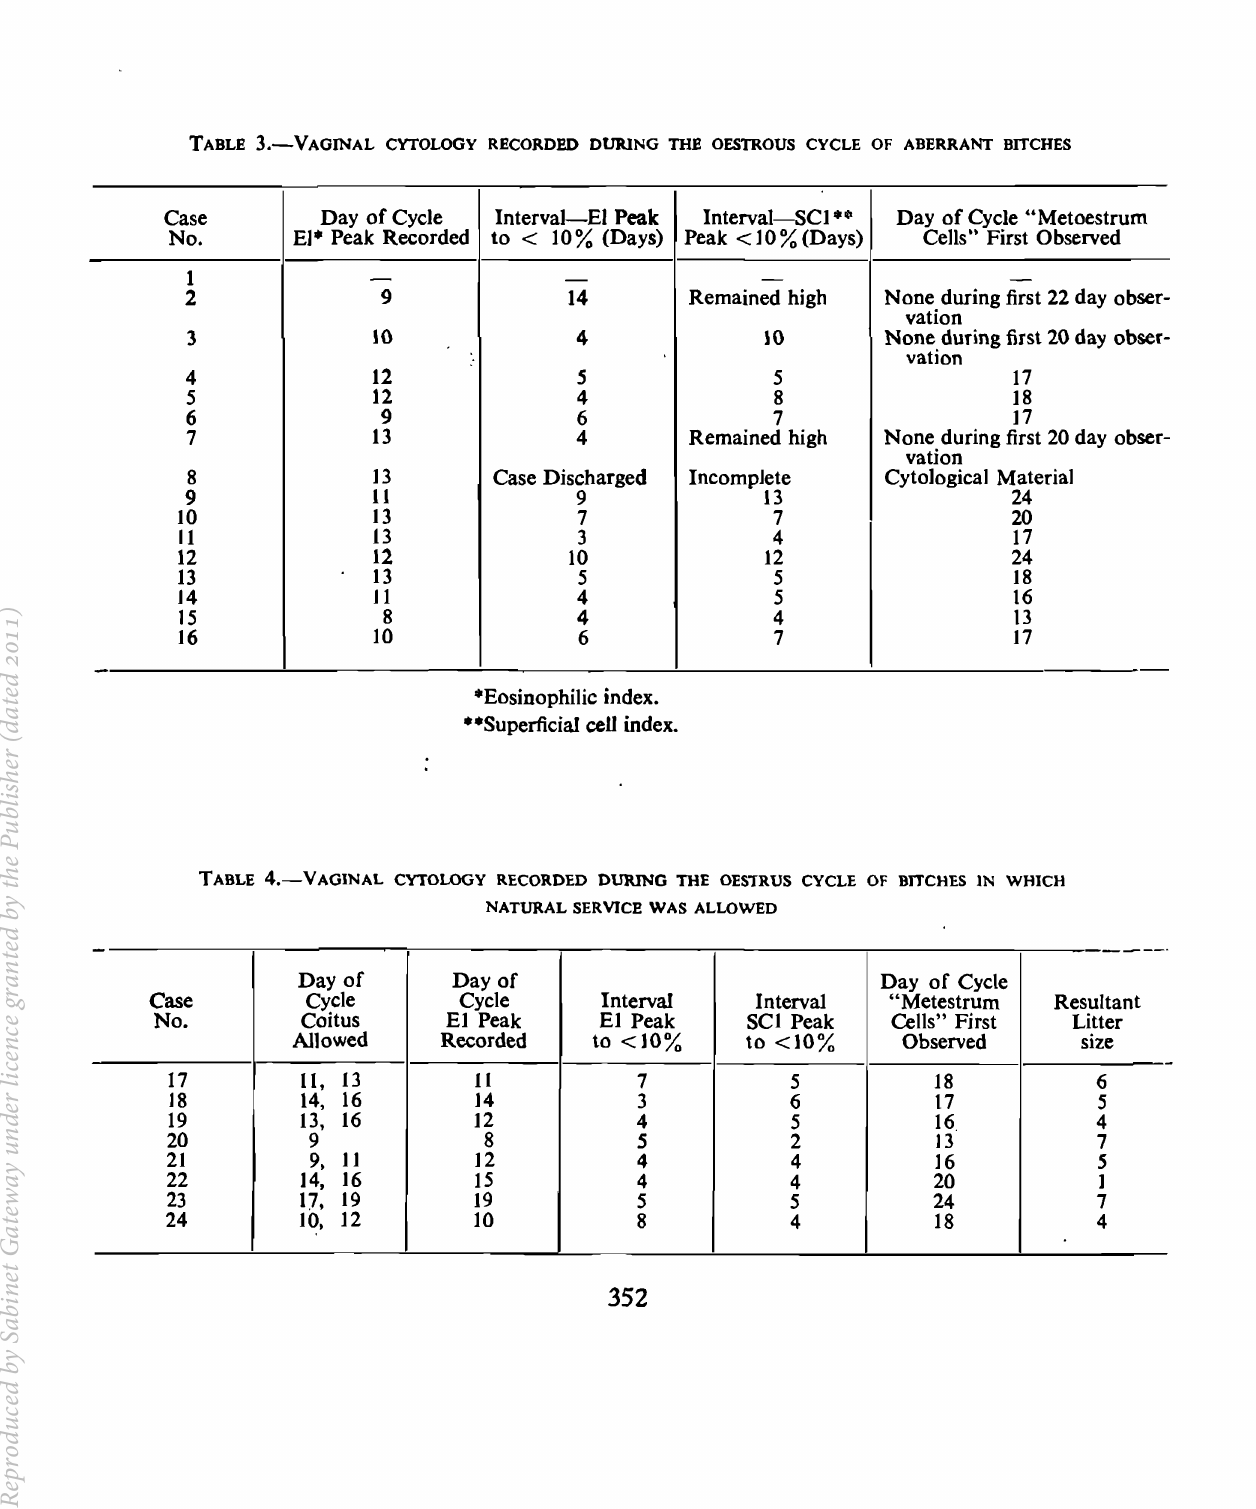
TABLE 3.-VAGINAL CYTOLOGY RECORDED DtllUNG THE OESTROUS CYCLE OF ABERRANT BITCHES